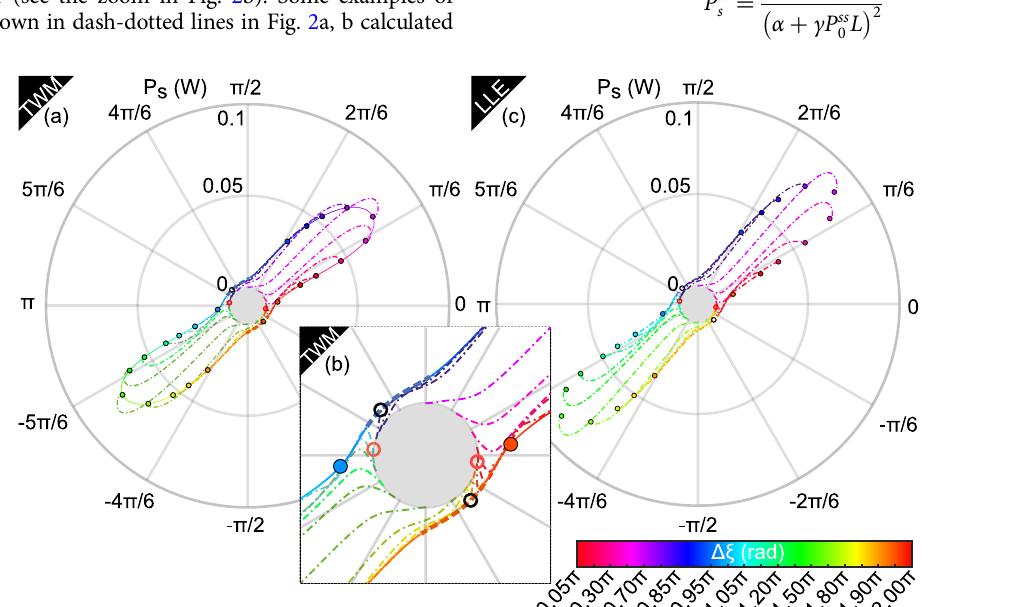
Fig. 2 Dynamic evolution in a phase plane. a Steady-states predicted from three wave mixing theory (TWM, see Supplementary Note 1) in the phase plane ( P s (Signal power), ϕ s − ϕ 0 (pump-signal signal phase difference)). Solid colored lines and dashed colored lines stand for the stable and unstable steady- states, respectively. Thin dash-dotted curves correspond to trajectories calculated from TWM (Eq. S4 in the Supplementary Note 1) for Δ ξ (relative input phase) ranging from 0 to 2 π . b Zoom around the origin of ( a ). The orange circles in ( a , b ) denote the initial states corresponding to the speci fi c input phases leading asymptotically towards the saddle points marked by the black circles (Eqs. 2 and 3). c Example of trajectories calculated from numerical simulations of the Lugiato Lefever equation (LLE, Eq. 4). In all cases, colored dots stand for the fi nal states. Parameters: δ 0 (pump cavity detuning) = 0.05 rad, α (cavity loss) = 0.14, L (cavity length) = 169 m, γ (nonlinear coef fi cient) = 1.2 W − 1 .km − 1 , P in (pump power) = 0.2 W, β 2 (group velocity dispersion) = − 20 ps 2 .km − 1 , P i / s , in (input idler and signal power) = 1.10 − 2 × P 0, in , f T (pump signal frequency shift) = ± Ω T /(2 π ) = ± 59 GHz. The origin has been expanded ( P s = 0, gray zone) in order to improve the